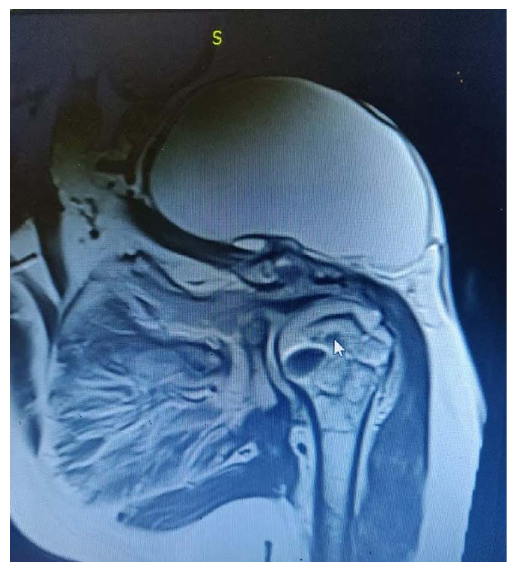
Figure 3. T2 weighted coronal MRI image of the shoulder showing the subcutaneous sac communicating to AC and Shoulder